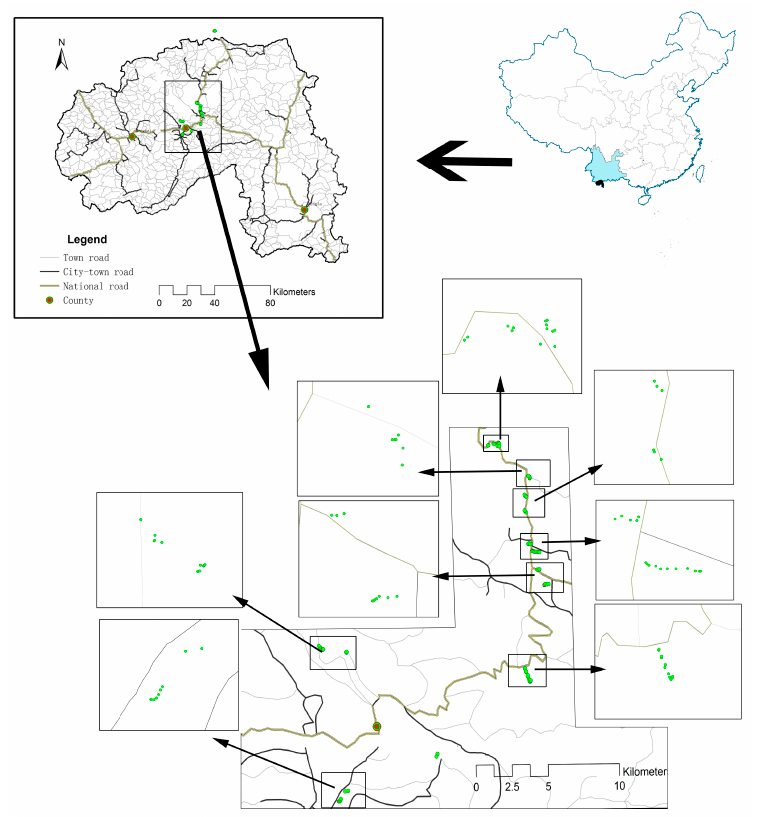
Figure 1. Location of the study region and sampling